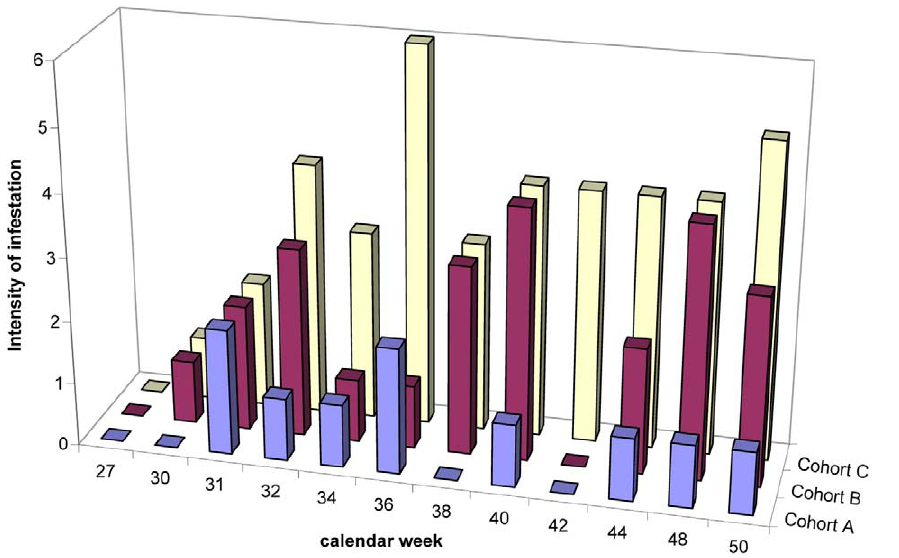
Figure 3. Number of viable lesions (stage I-III of the Fortaleza Classification) during the study period. No follow-ups were carried out between calendar weeks 45–47 (see Materials and Methods).